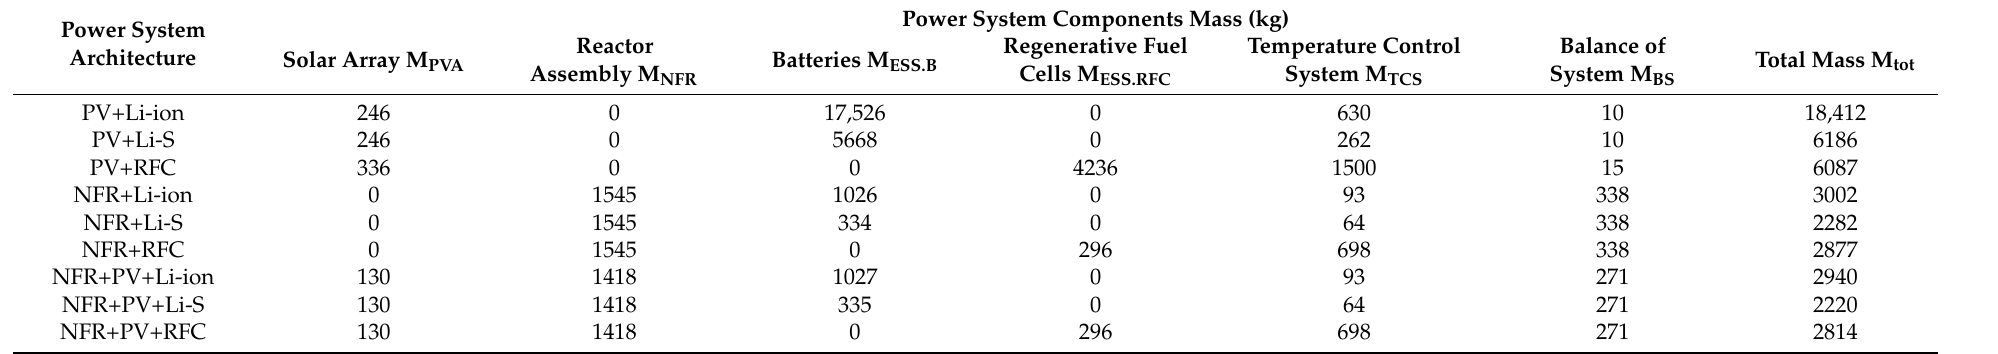
Table 10. Baseline configuration power systems